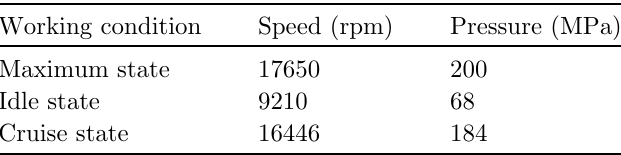
Table 5. Centrifugal load on blade corresponding to various speeds of turbine disc.